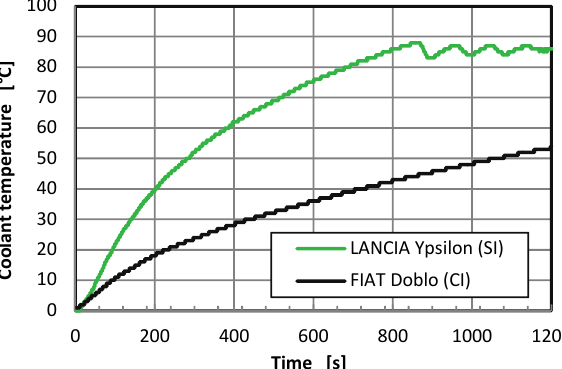
Fig. 10. The coolant temperature at the ambient temperature 0°C